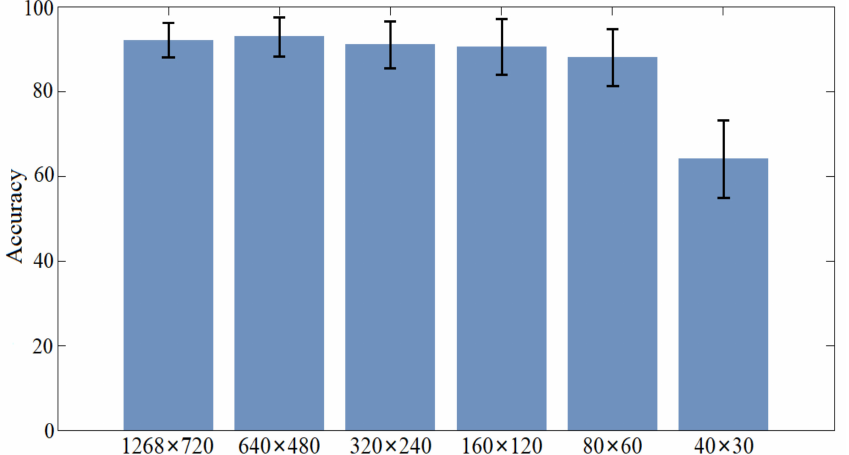
Figure 17. Effect of image resolution on accuracy.